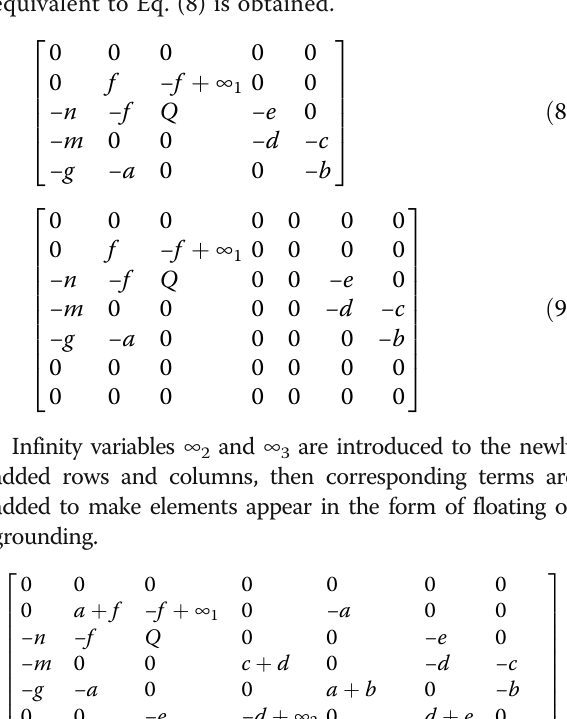
Table 2 Component values of the designed band-pass filter